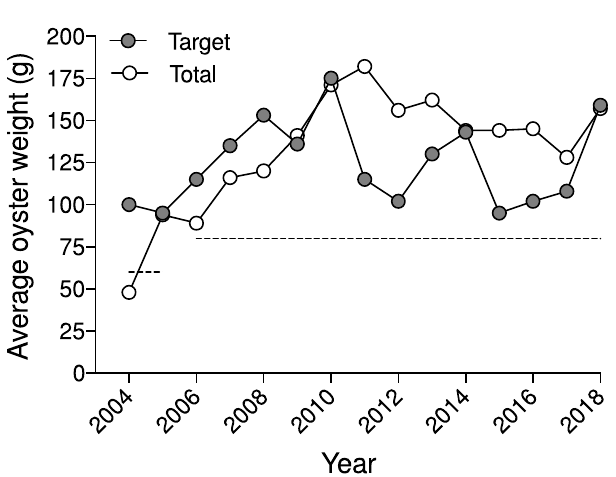
Fig. 6. The estimated average individual weight (g) for the total oyster ( Ostrea edulis ) population and target oysters (60 – 175g in 2004 – 2005 and 80 – 175 g in 2006 – 2018). The horizontal dotted lines indicate the minimum landing sizes (60 or 80 g) of O. edulis for the given years. Data are from the annual stock surveys done in 2004 – 2018 in the Limfjorden, Denmark.